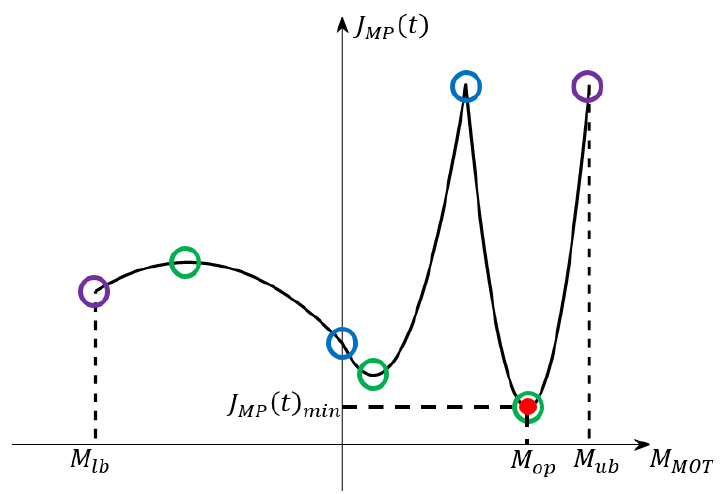
Figure 6. The optimal point identification for one